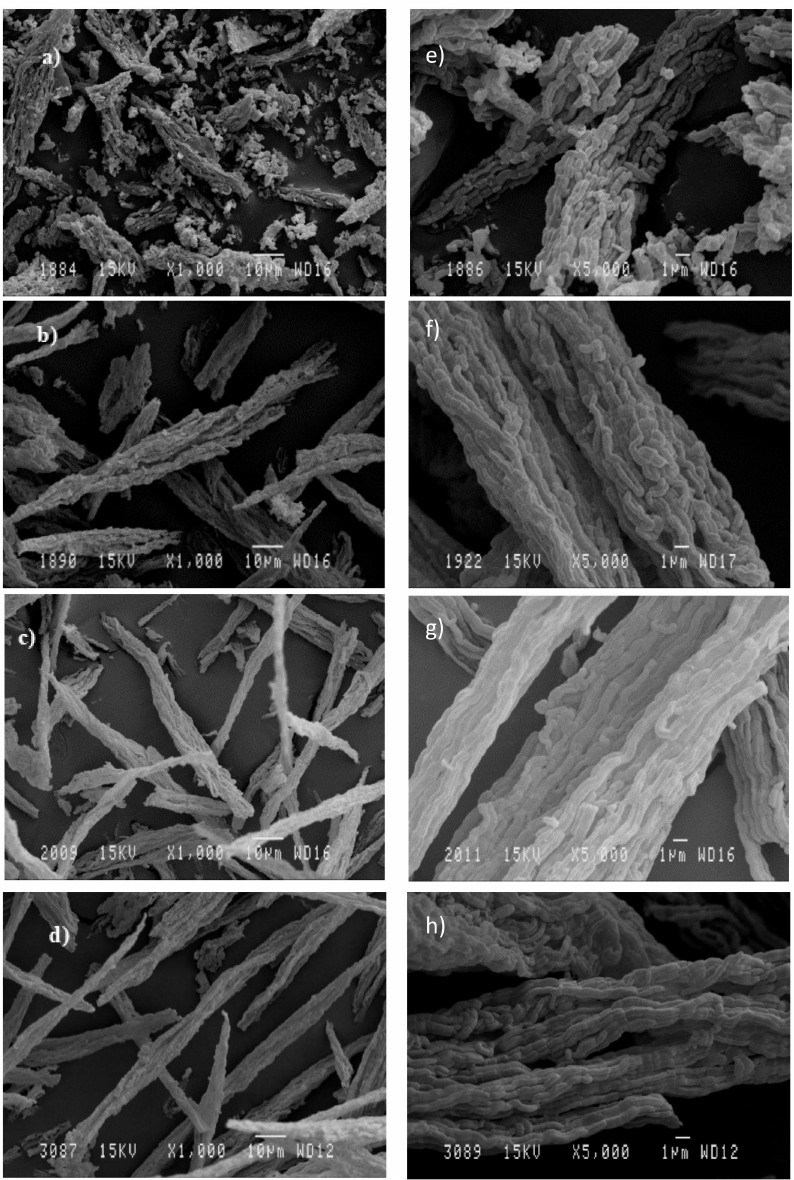
Figure 1. SEM images of the samples prepared at different hydrothermal treatment times and magnifications: ( a , e ) H0, ( b , f ) H6, ( c , g ) H15 and ( d , h )